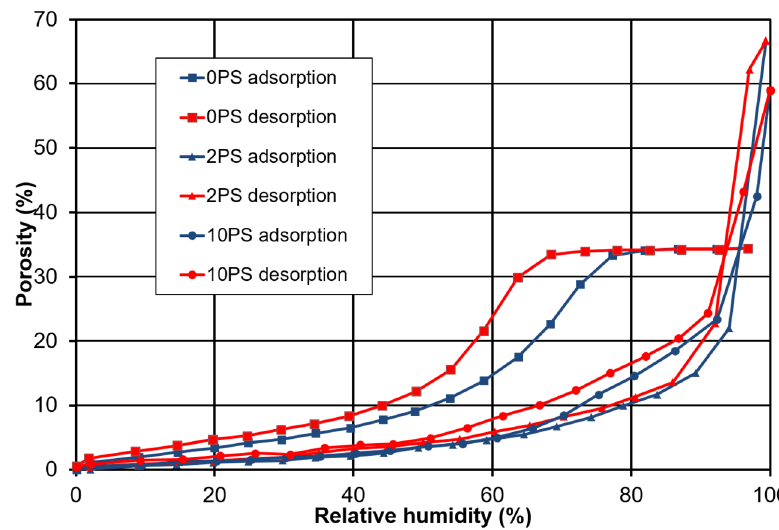
Figure 8. Porosimetry isotherms for 1:3 diluted SiO 2 nanoparticles with increasing polystyrene (PS) ratio. Table 1. The thickness and refractive index as measured by ellipsometry as a function of spin rate in RPM. As the spin rate decreases, the thickness decreases and the refractive index increases.